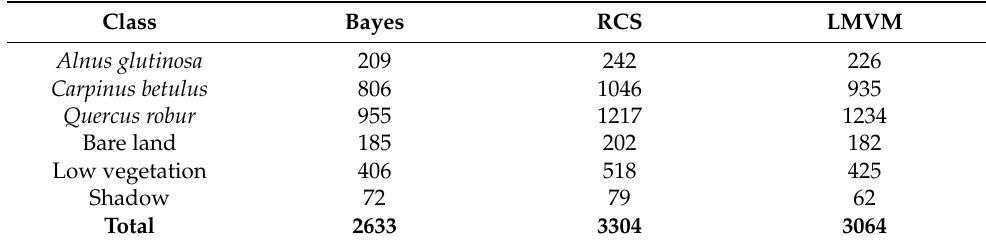
Table 1. Number of reference polygons for object-based